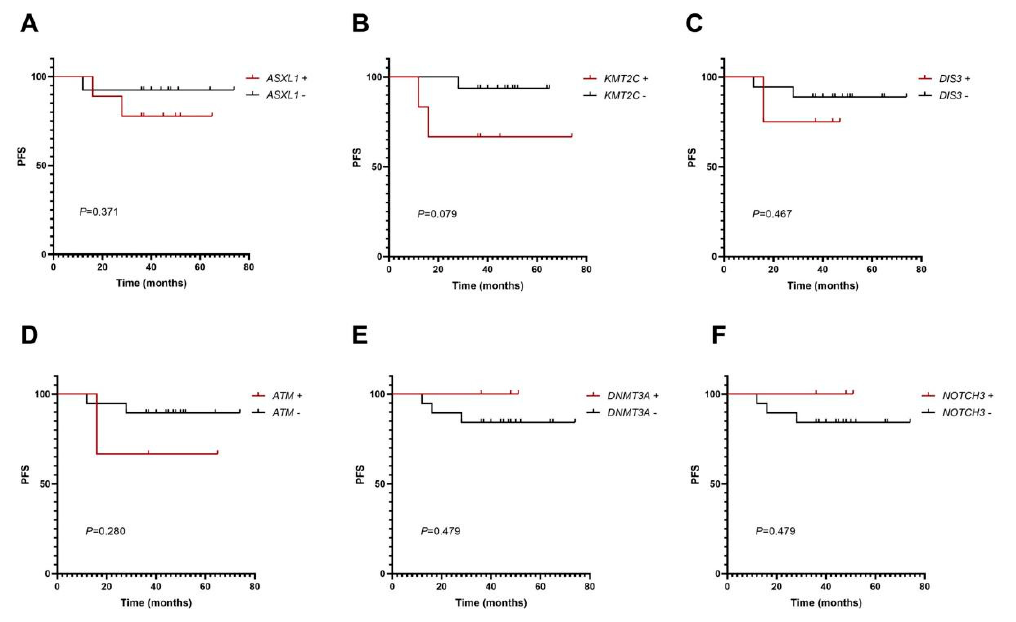
Figure 4. Analysis of ASXL1 ( A ), KMT2C ( B ), DIS3 ( C ), ATM ( D ), DNMT3A ( E ) and NOTCH3 ( F ) mutations on PFS in CML-CP patients.